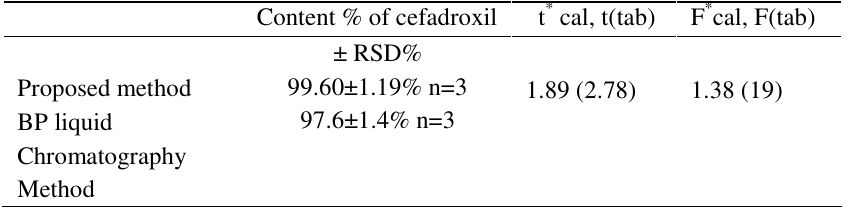
Table 3. Validation results of proposed method compared to the BP method